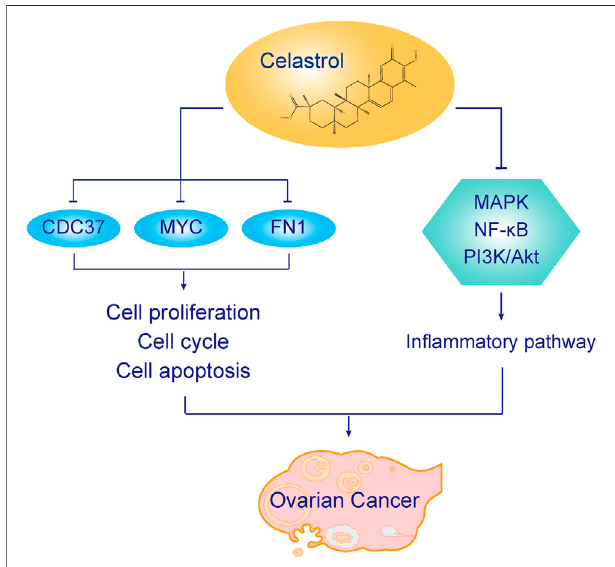
FIGURE 13 | The mechanism underlying the therapeutic effect of celastrol on ovarian